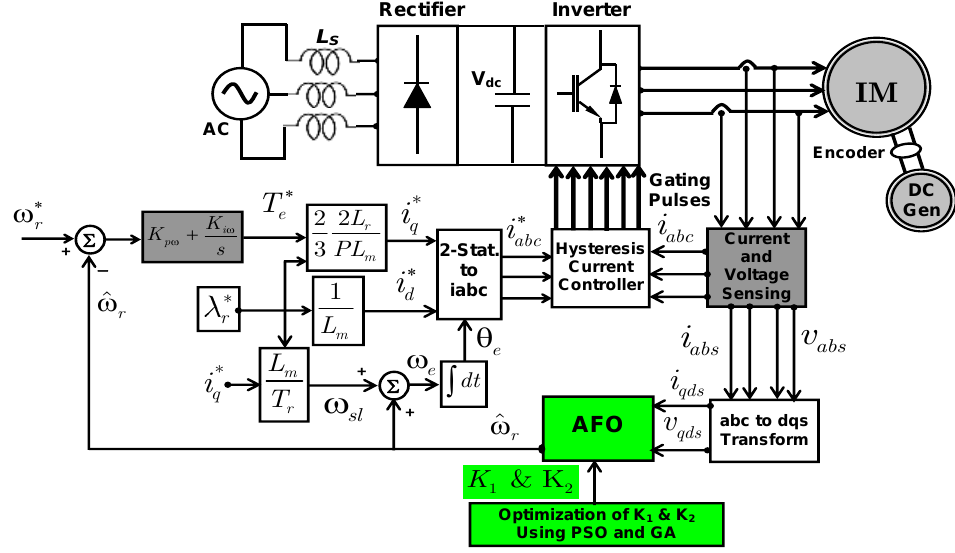
Figure 1. Block diagram of IFOC for a SIM drive with AFO. “*” means the reference variable.